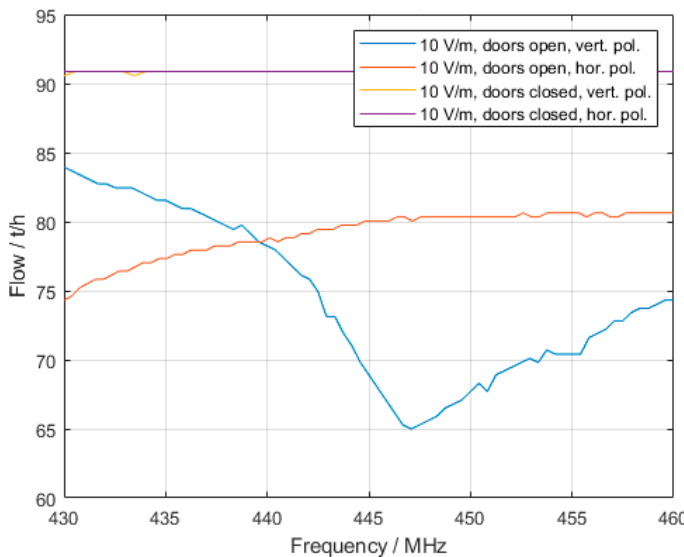
Figure 4. Signal processing card response for different test wave polarizations and open/closed cabinet doors.